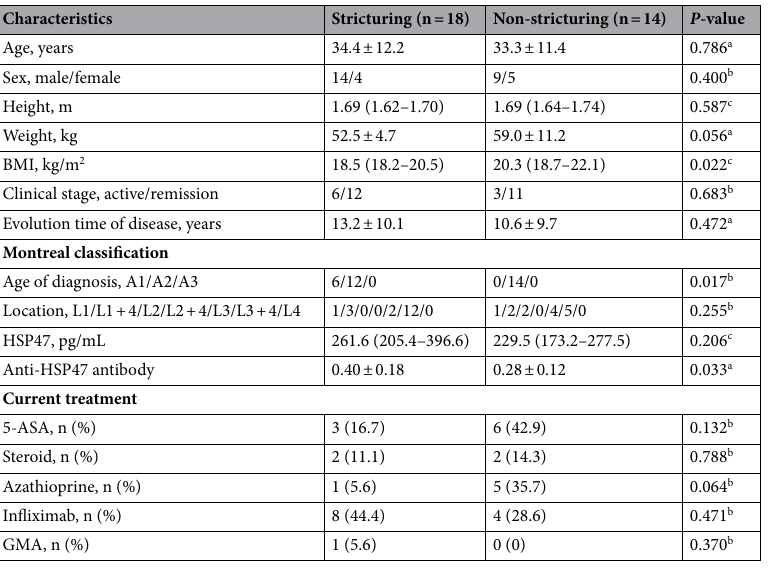
Table 3. Characteristics of patients with CD with and without intestinal structuring. Clinical active stage was defined as CAI > 4 for UC and CDAI > 150 for CD. Montreal classification of CD: A1, age < 16 years; A2, age 17–40 years, A3, age > 40 years, L1 ileal, L2 colonic, L3 ileocolonic, L4 isolated upper disease, B1 non-structing and non-penetrating, B2 structing, B3 penetrating, p perianal, CDAI Crohn ʼ s disease activity index, BMI body mass index, HSP heat shock protein, GMA granulocyte-monocyte apheresis. a Student’s t test; b Chi-square test; c Mann–Whitney U test.